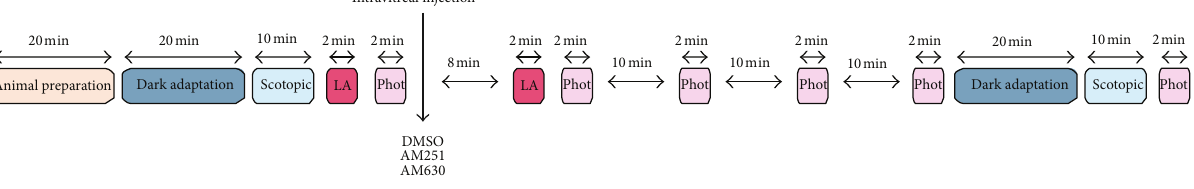
Figure 1: A schematic procedure illustrating a typical ERG recording session for testing ERG changes following an intravitreal injection in vervet monkeys (modified from [40]). LA, light adaptation; Phot,